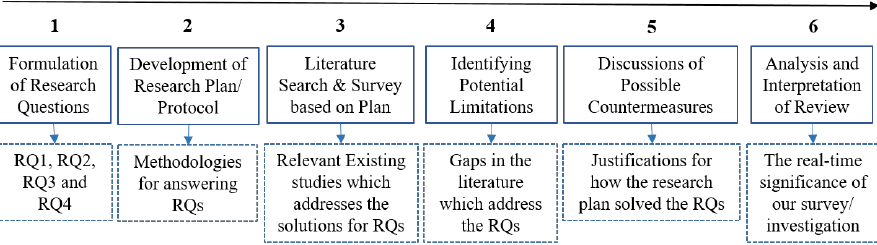
Figure 4. Flow of our systematic